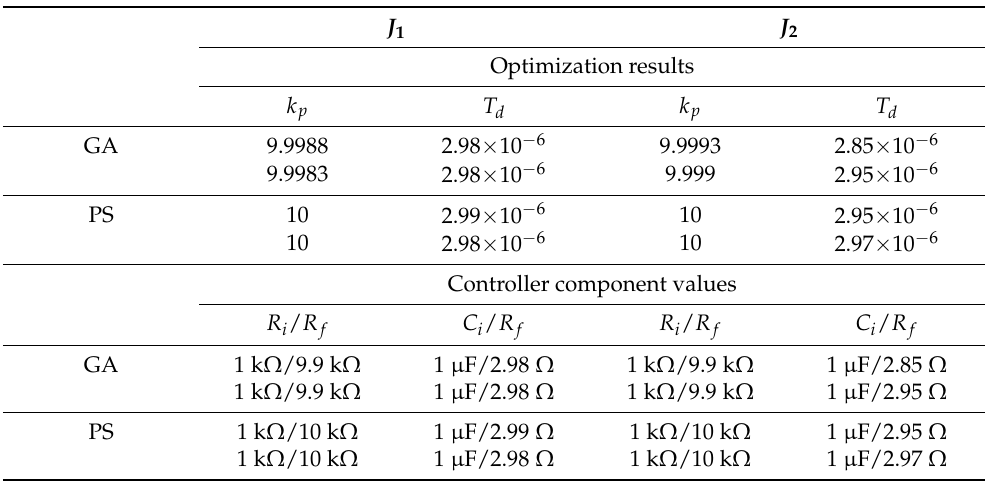
Table 6. Optimized parameters and component values from minimizing criteria (9), (10) and phase margin φ d when a classical PD controller is being used.